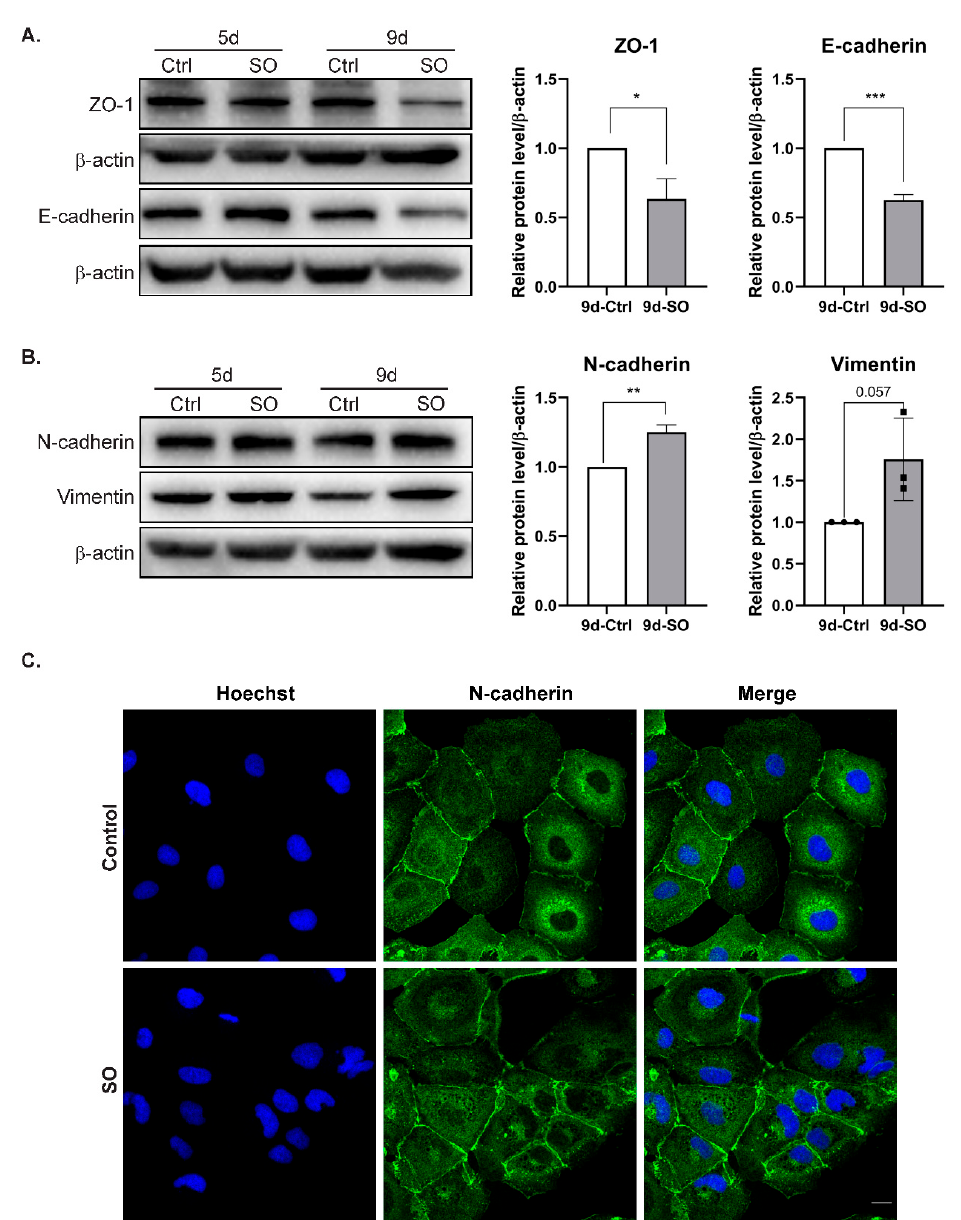
Figure 3. The effect of sodium oleate on the level of epithelial and mesenchymal markers in Huh7 cells after five and nine days of stimulation. ( A ) Analysis of epithelial markers (E-cadherin, ZO-1) level using the Western blot method. On the right, densitometric analysis from three independent repetitions: Huh7 cells after nine days of stimulation with sodium oleate, the control was set to 1, Ctrl—control, SO—0.5 mM sodium oleate. β -actin was used as the loading control. ( B ) Analysis of mesenchymal marker (N-cadherin, vimentin) levels using the Western blot method. On the right, densitometric analysis from three independent repetitions: Huh7 cells after nine days of stimulation with sodium oleate; the control was set to 1, Ctrl—control, SO—0.5 mM sodium oleate. β -actin was used as the loading control. ( C ) Representative images from a confocal microscope analysis of N-cadherin in the Huh7 cells stimulated with sodium oleate for five days (63 × magnification, Hoechst for nuclei, scale bar, 20 µ m). Primary antibody: rabbit polyclonal to N-cadherin 1:200 (Abcam), secondary antibody: Alexa Fluor 488 goat anti-rabbit (Thermo Fisher). The results are presented as the means ± SD, the Student’s t -test was used to determine the p -value, * p < 0.05; ** p < 0.01; *** p <